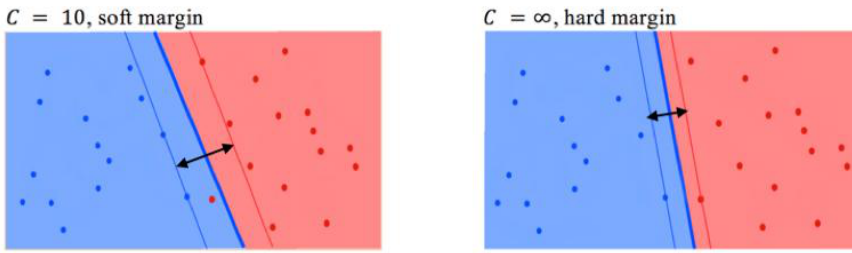
Figure 6. Examples of regularization parameter influence in the case of the two-dimensional classification problem. Red and blue points are training samples. The double arrow is hyperplane margin.